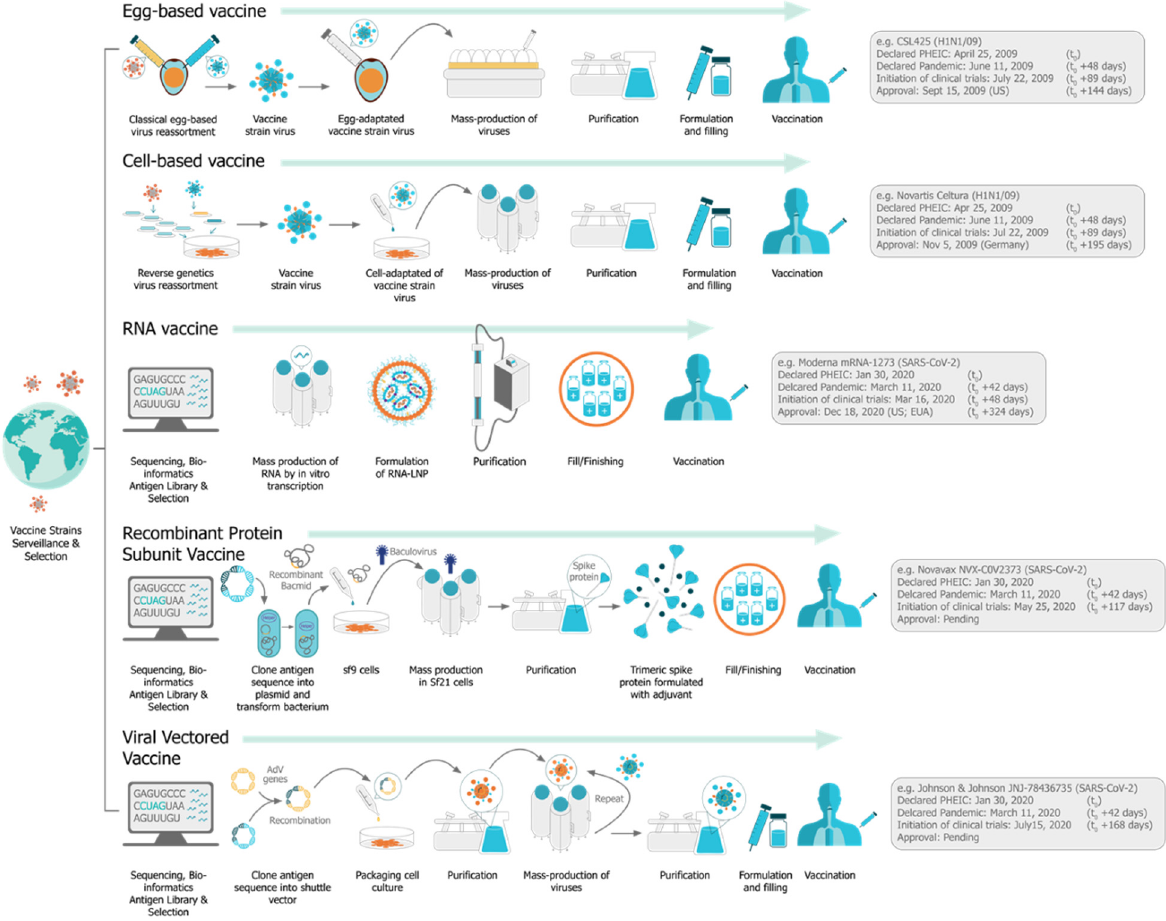
Figure 7. A comparison of vaccine drug product manufacturing processes for egg- and cell-based manufacturing of conventional vaccines, as well as vaccines produced from viral genome sequence information such as the RNA, protein subunit, and viral vectored DNA vaccines against SARS-CoV-2 from Moderna, Novavax, and Johnson & Johnson respectively [130–143]. RNA vaccines offer a cell-free manufacturing process that is responsible for many advantages of the platform, allowing facile and rapid vaccine manufacturing. Moderna’s mRNA vaccine against SARS-CoV-2 (mRNA-1273) began clinical trials just 63 days following the publication of the SARS-CoV-2 genome. * For comparative purposes, we have included historical timelines for the flu pandemic vaccines for egg and cell culture production, but it should be noted that large efficacy trials are not required for these vaccines since they are licensed based on a correlate of protection (hemagglutination inhibition (HI) antibody